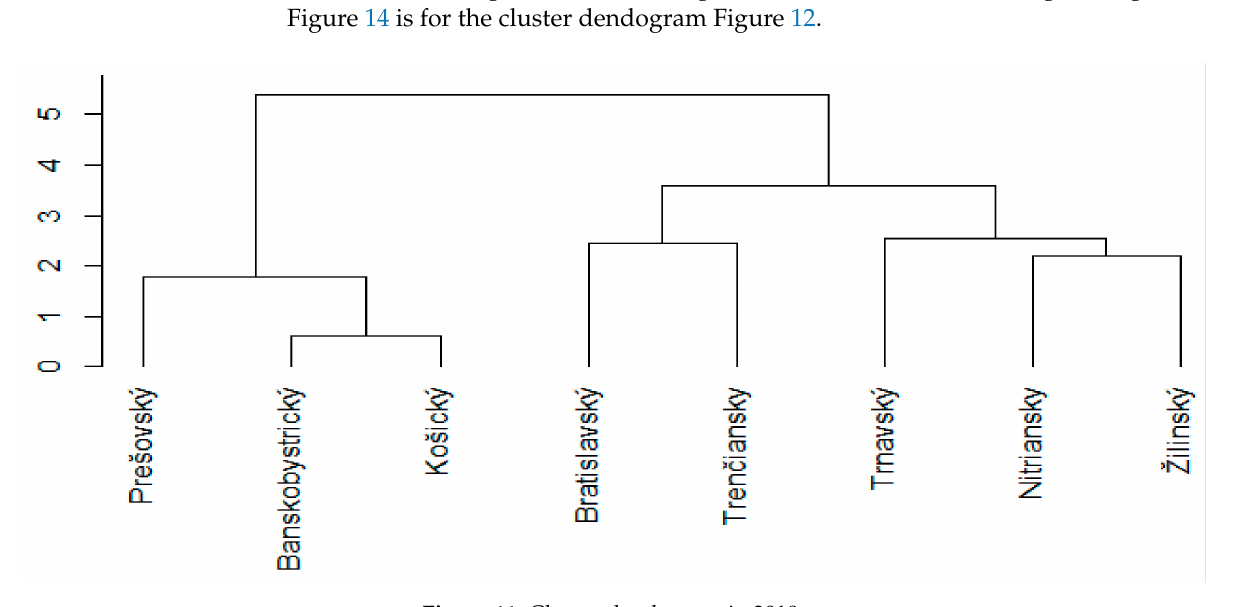
Figure 11. Cluster dendogram in 2018.